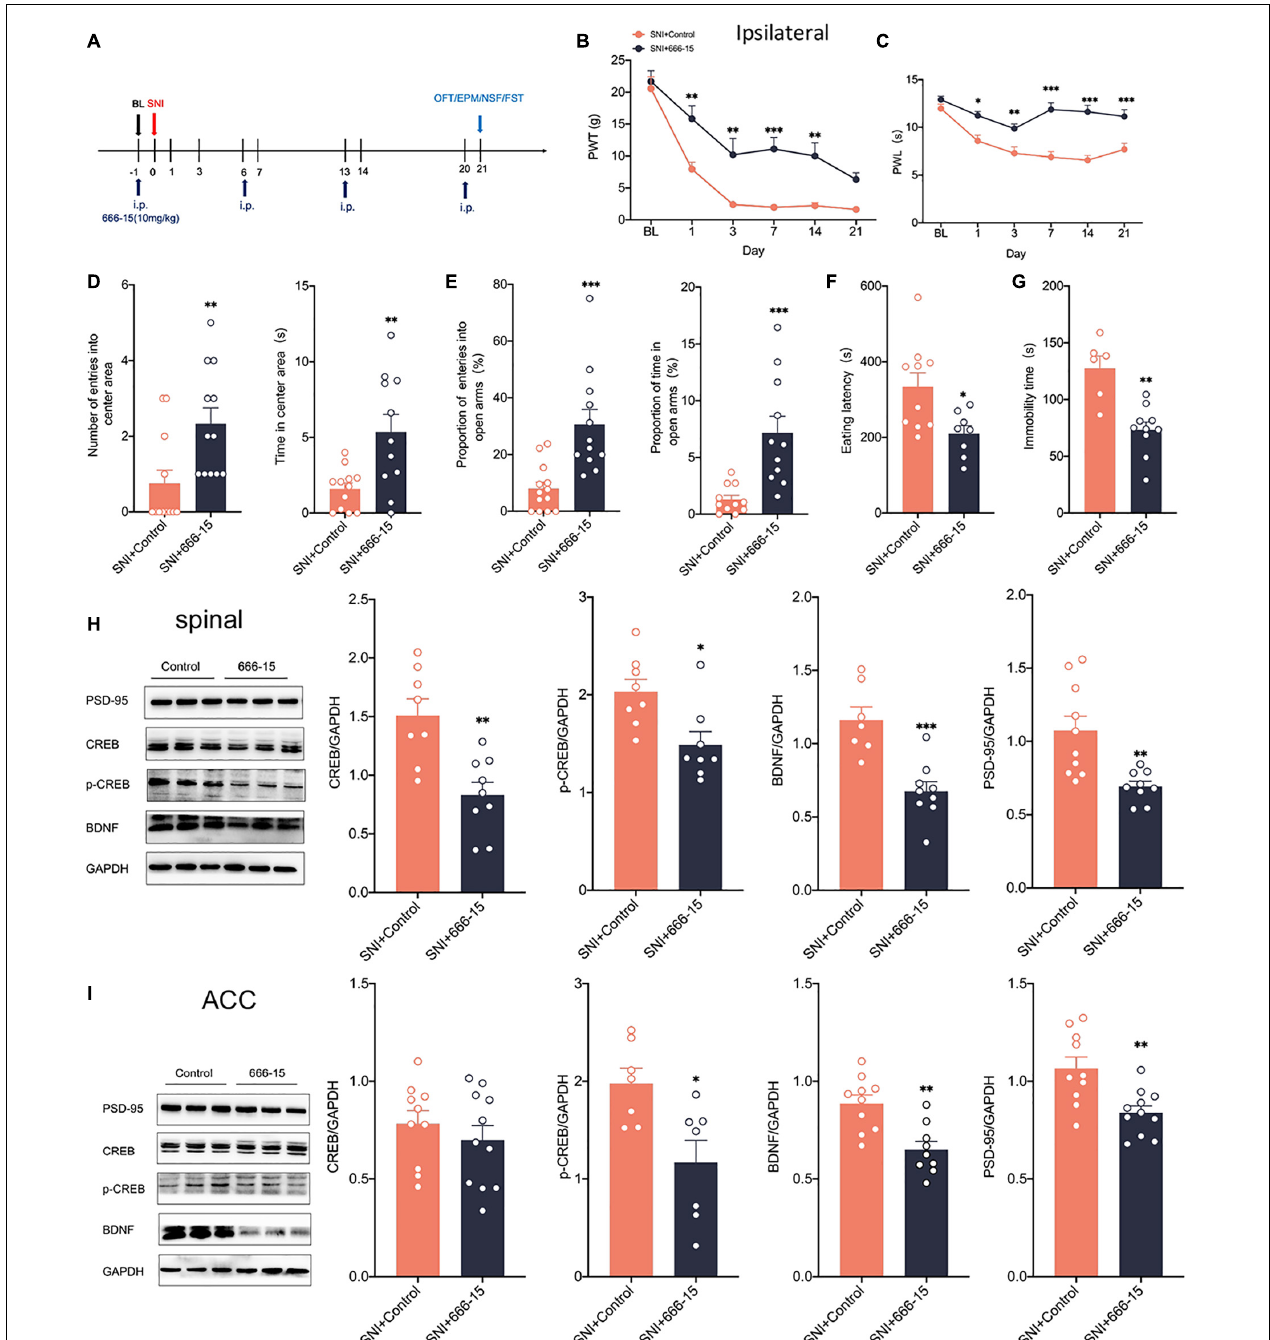
FIGURE 8 | Intraperitoneal administration of the CREB inhibitor (666–15) reduced neuropathic pain and anxiodepression like behaviors in SNI rats. (A) 666–15 (10 mg/kg) was administered intraperitoneally 1 day before surgery and at 7 days intervals thereafter. (B,C) Intraperitoneal injection of 666–15 attenuated PWT (B) and PWL (C) in SNI rats ( n = 12 rats/group). (D) Intraperitoneal injection of 666–15 increased the number of entries into the center area and the time in the center area in SNI rats ( n = 12 rats/group). (E) Intraperitoneal injection of 666–15 increased the proportion of entries into the open arms and the proportion of time in the open arms in SNI rats ( n = 12 rats/group). (F,G) Intraperitoneal injection of 666–15 decreased the eating latency (F) and the immobility time (G) in SNI rats ( n = 12 rats/group). (H) Intraperitoneal injection of 666–15 suppressed the CREB/BDNF pathway in the spinal cord ( n = 8 rats/group). (I) Intraperitoneal injection of 666–15 decreased the expression of p-CREB, BDNF, and PSD, but not CREB, in the ACC ( n = 8 rats/group). ∗ P < 0.05, ∗∗ P < 0.001, ∗∗∗ P < 0.0001 for SNI + Control vs. SNI + 666–15.